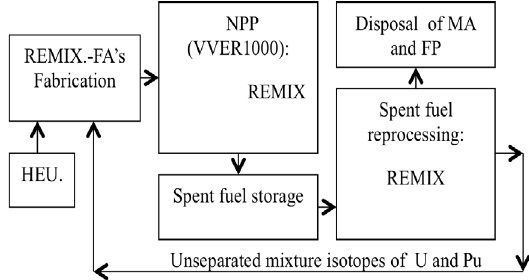
Fig. 1. Flowchart with REMIX-fuel with